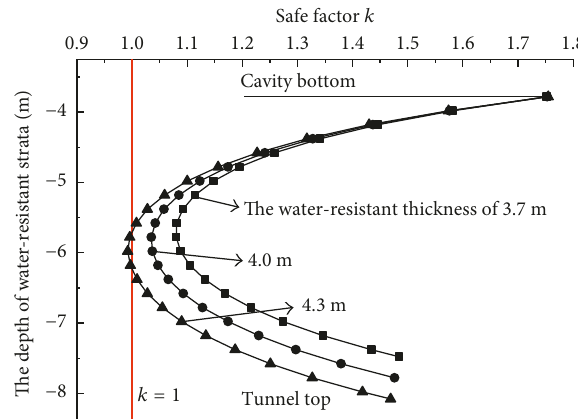
Figure 12: The critical water-resistant thickness of the engineering example on Yichang-Wanzhou Railway.